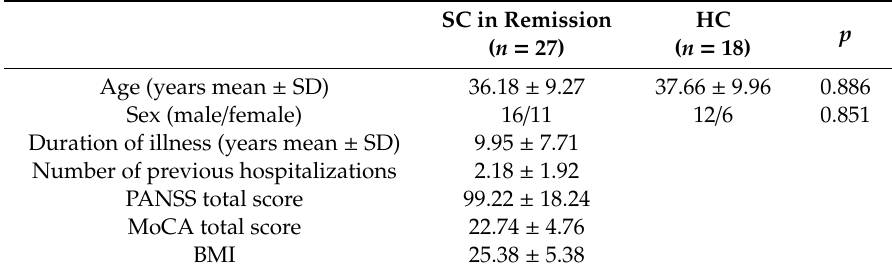
Table 1. Demographic and clinical